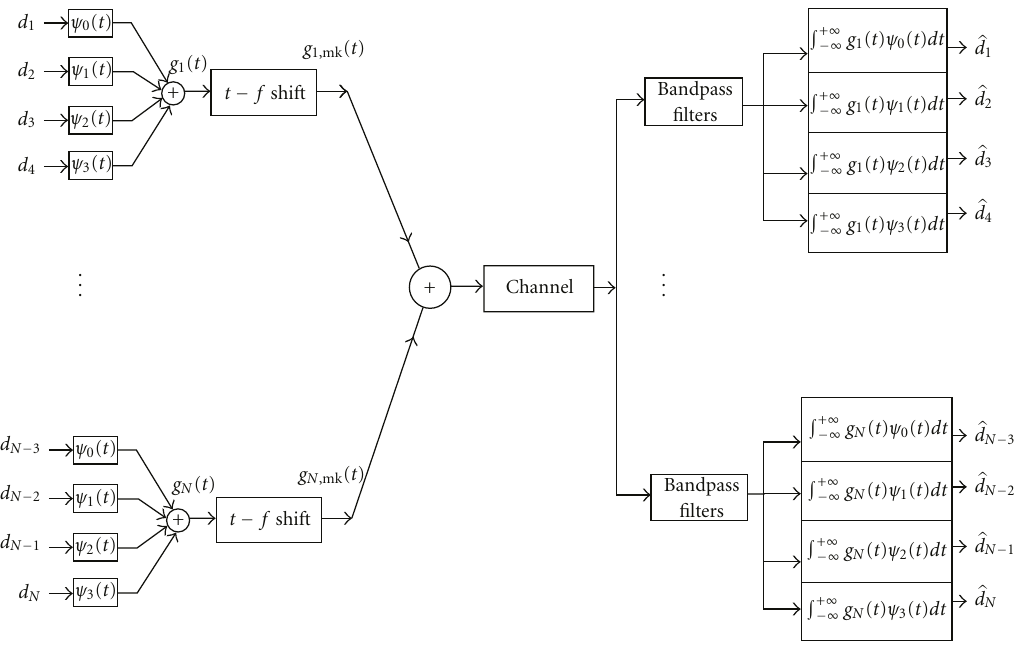
Figure 1: The proposed system model. Hermite-Gaussian functions are combined to form each symbol.